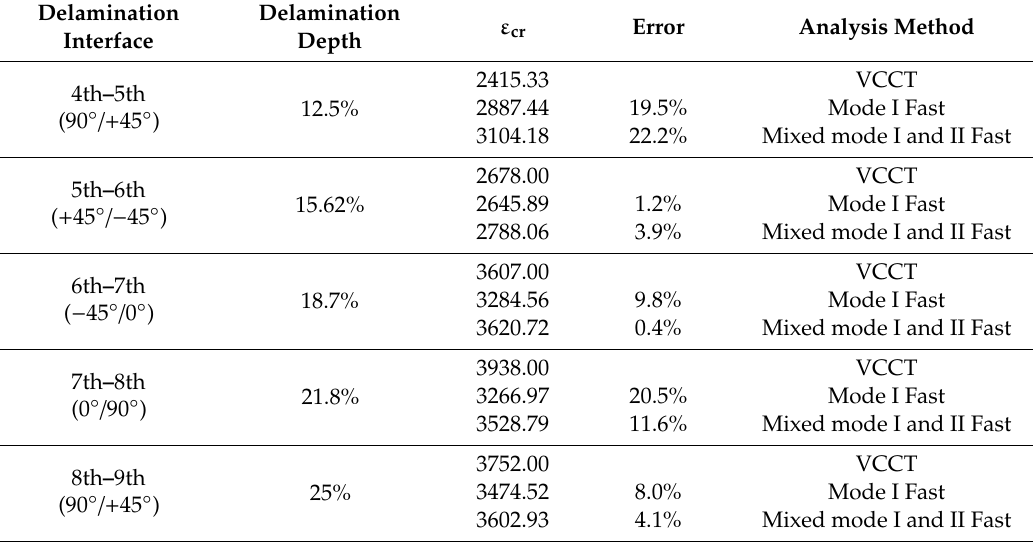
Table 4. Results summary for SS#1 damage configuration (25 mm radius delamination).